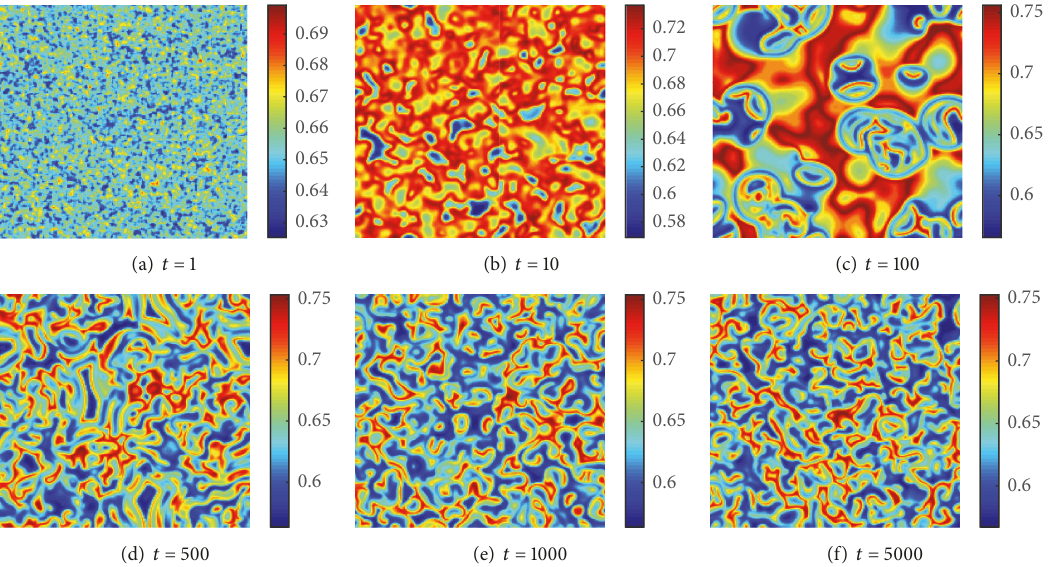
Figure 4: Pattern formation resulting from spatially symmetry breaking on period-31 orbit and starting with stochastic initial condition. 𝑎 = 1.63, 𝑏 = 0.1, 𝑐 = 0.32, 𝑑 = 0.22, 𝐷 1 = 0.6, 𝐷 2 = 1.2, 𝜏 = 5.525, 𝛿 = 10, and 𝑛 =